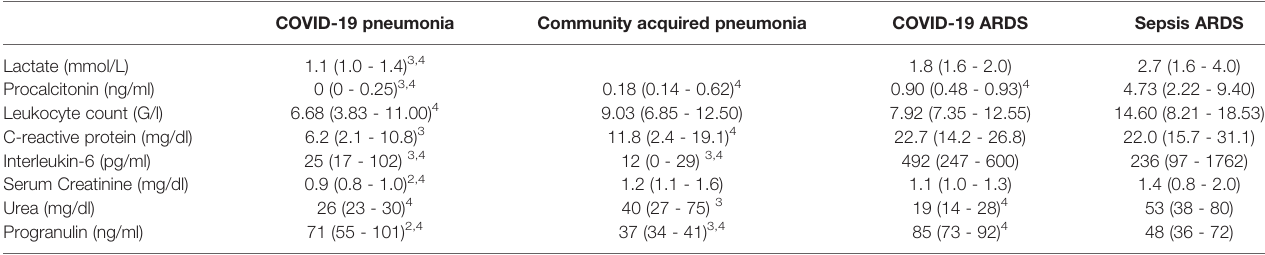
TABLE 3 | Laboratory results of different patient groups.